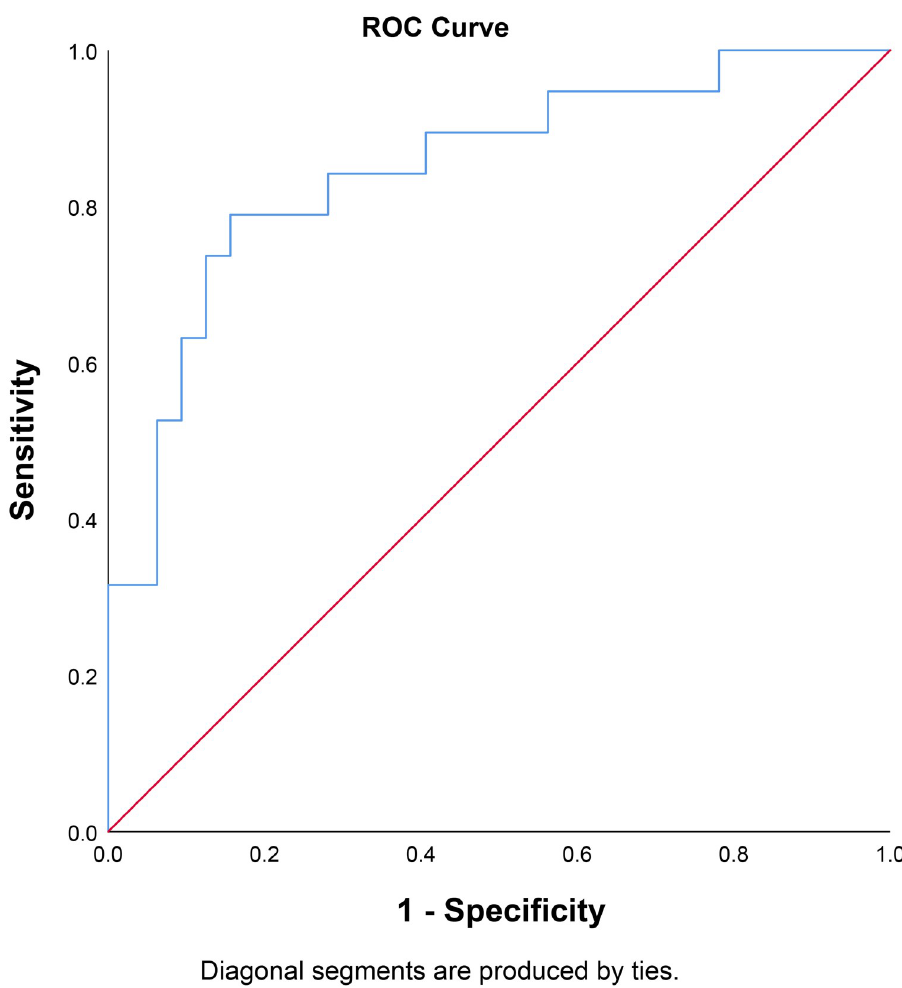
Fig 1. Receiver operating characteristic curve for FIB-4 and mortality.